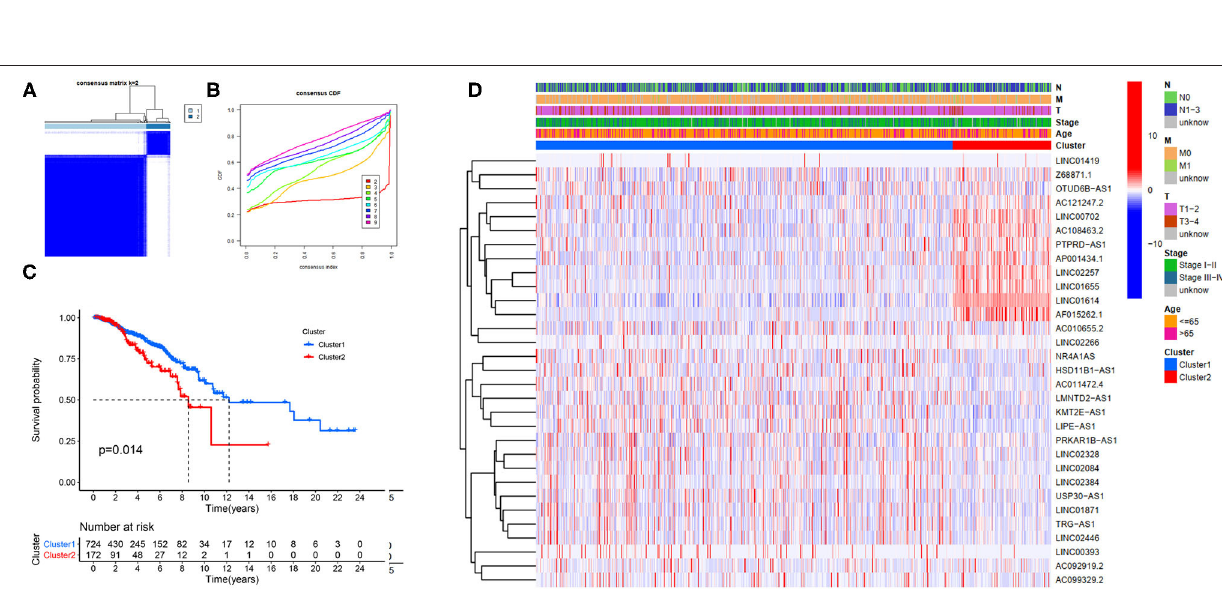
Frontiers in Surgery |